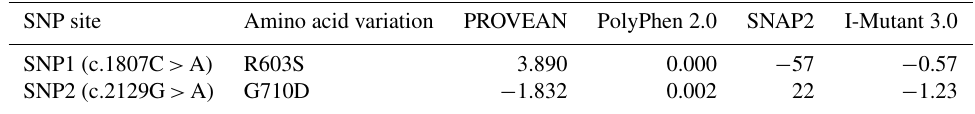
Table 5. Prediction results of destructiveness of the MLPH gene nsSNPs. SNP site Amino acid variation PROVEAN